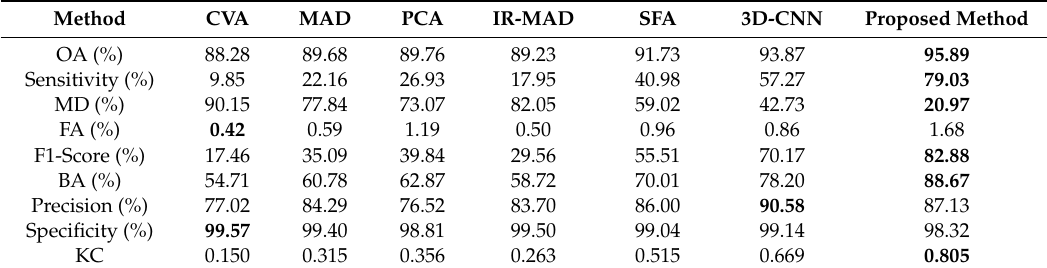
Table 13. The accuracy of different change detection methods for the PolSAR-San Francisco2 dataset (the best performance for each method appears in bold).